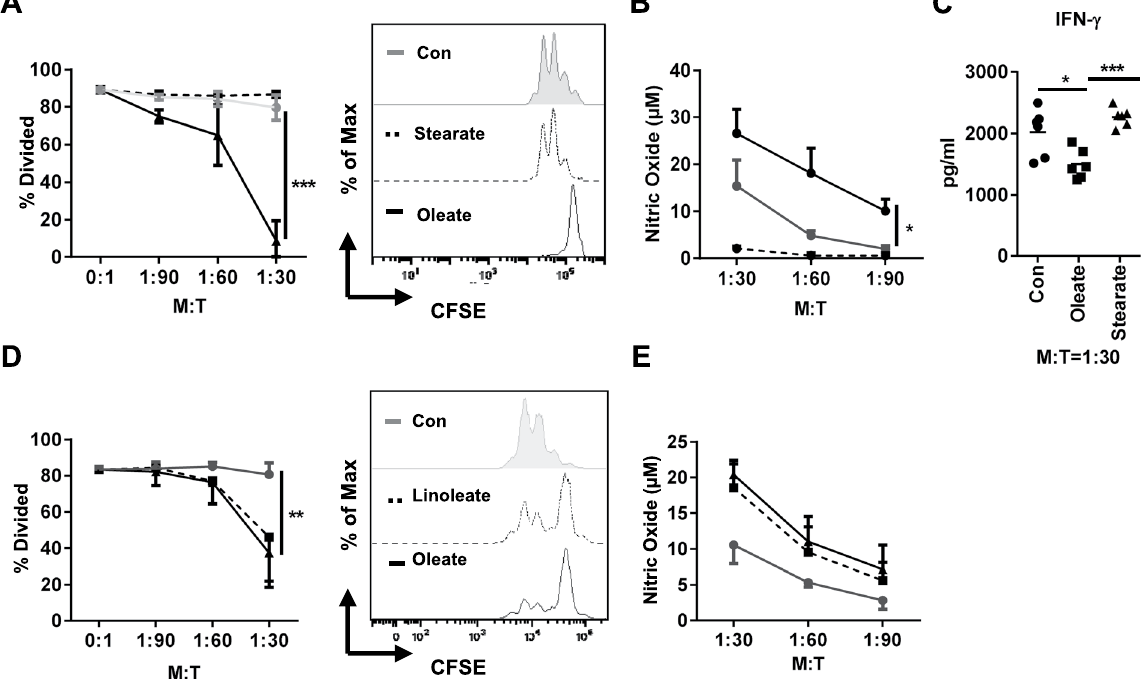
Figure 6. Both sodium oleate and sodium linoleate induces a regulatory phenotype in bone marrow-derived myeloid cells. Bone marrow cells isolated from naïve mice were cultured with GM-CSF (40 ng/ml) and FFA as indicated for 7 days. FFA-treated cells or controls were co-cultured with CD4 + T cells in the ratios as indicated. Cell proliferation was evaluated by CFSE staining after 72 h ( A/E ). Supernatants were served for NO analysis ( B/F ) and IFN γ detection ( C ). Shown is the mean ± SD from two to four independent experiments. * p < 0.05; ** p ≤ 0.01; *** p ≤